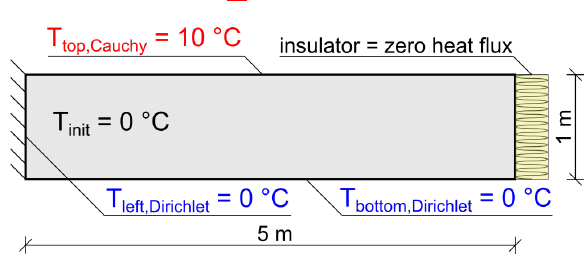
Figure 3. Schema of a thermo-mechanical task.